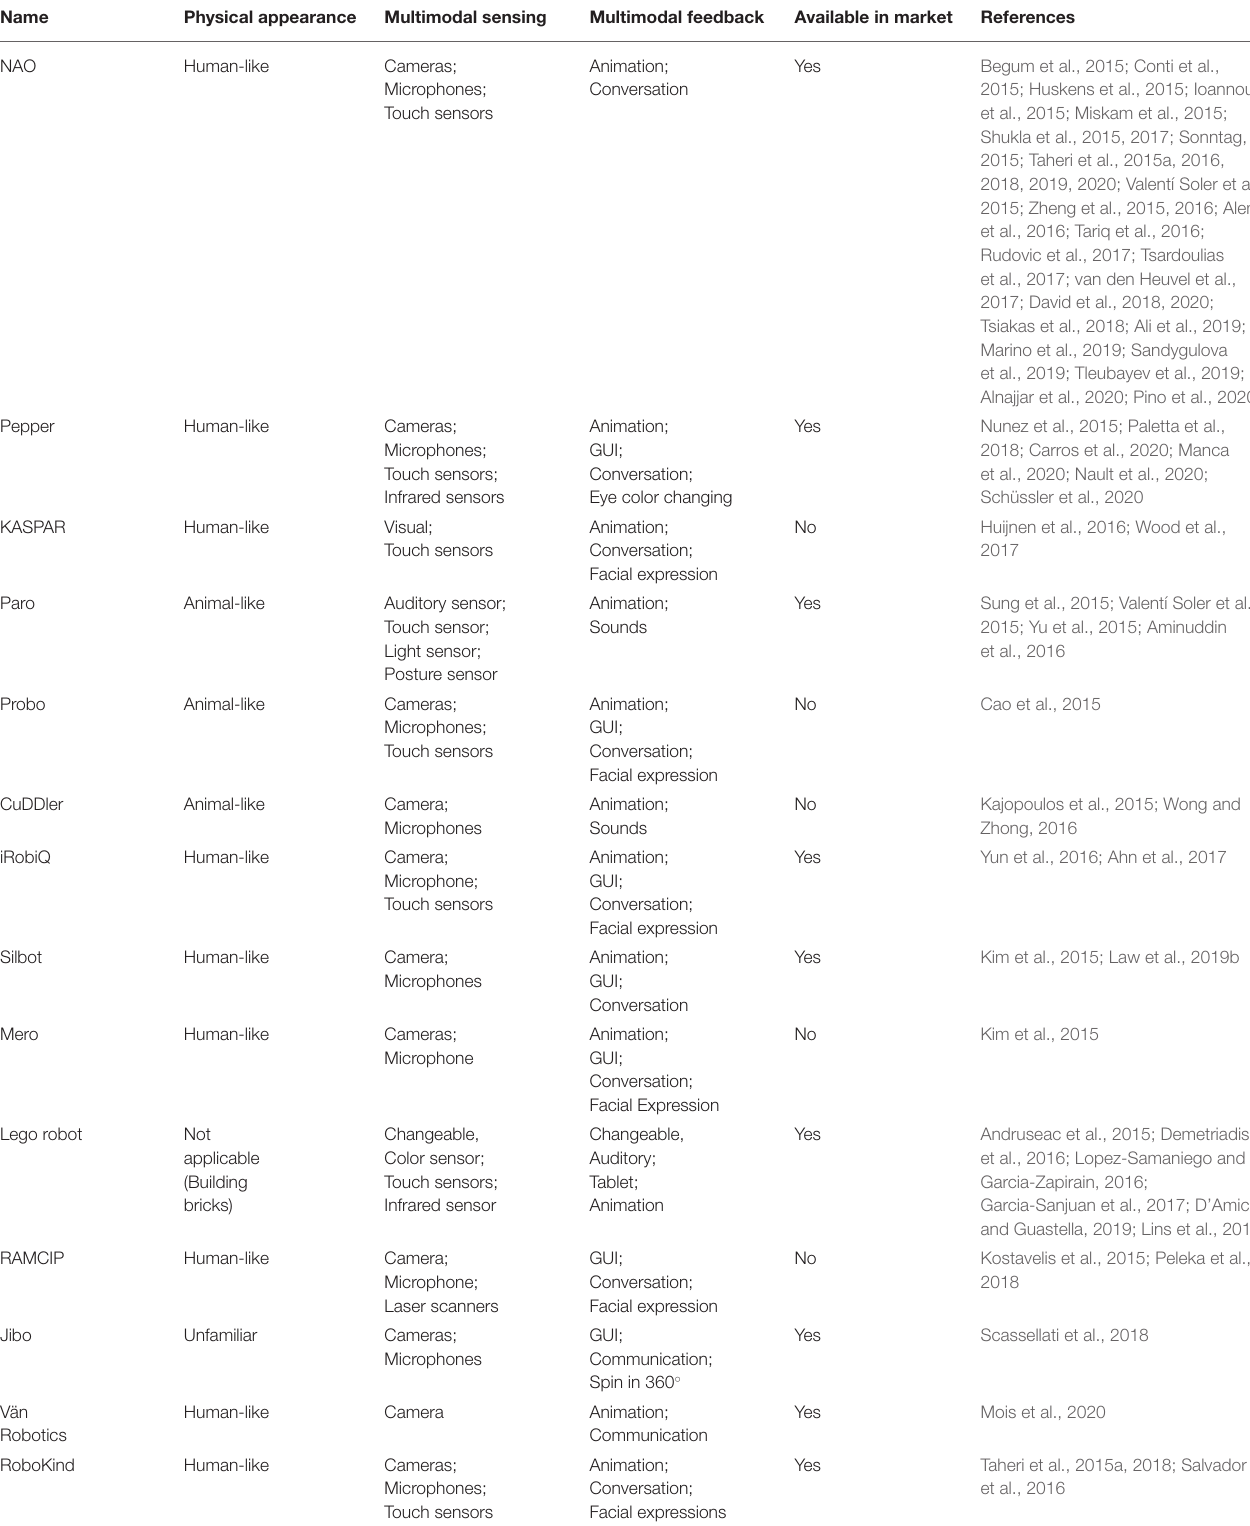
TABLE 4 | Features of common robot products for cognitive